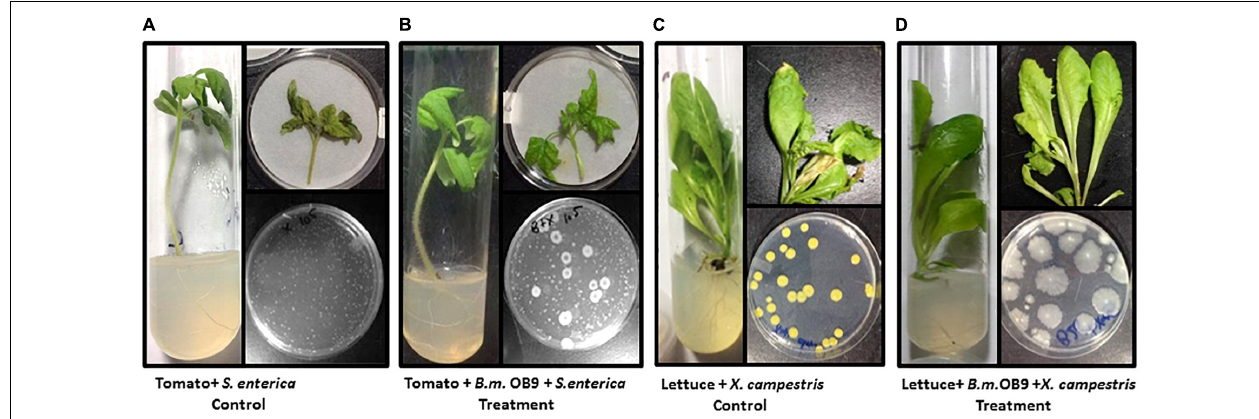
FIGURE 6 | Suppression of Salmonella and Xanthomonas growth in bacterized plants with B . methylotrophicus OB9. (A) Control treatment (tomato + S. enterica Newport SL1) displays a tomato seedling in tissue culture infected with S. enterica Newport SL1. Recovery of S. enterica Newport SL1 from an infected detached leaf representative of CFU/gram tissue is depicted on the agar plate. (B) Treatment (Tomato + B.m OB9 + S. enterica )-consisting of a tomato seedling in tissue culture bacterized with Bacillus methylotrophicus OB9 and infected with S. enterica Newport SL1. Recovery of OB9 and SL1 cells expressed as CFU/gram tissue as depicted on the agar plate. (C) Control treatment (Lettuce + X. campestris ) showing a lettuce seedling in tissue culture infected with X. campestris B07.007. Recovery of X. campestris cells on culture medium from infected leaves indicative of the CFU/gram tissue. (D) Treatment (lettuce + B.m. OB9 + X. campestris) of a lettuce seedling in tissue culture bacterized with B. methylotrophicus OB9 and infected with X. campestris B07.007. Recovery of B. methylotrophicus OB9 but not X. campestris B07.007 on culture medium from detached bacterized leaves treated and infected with X. campestris B07.007 as depicted on the agar plate and representative of the CFU/gram